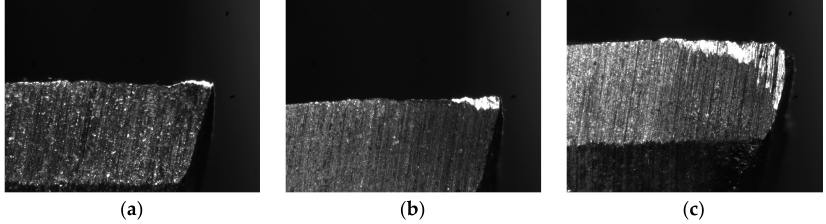
Figure 10. ( a ) The tool image of the initial wear stage, ( b ) the normal wear stage, and ( c ) the sharp wear stage.